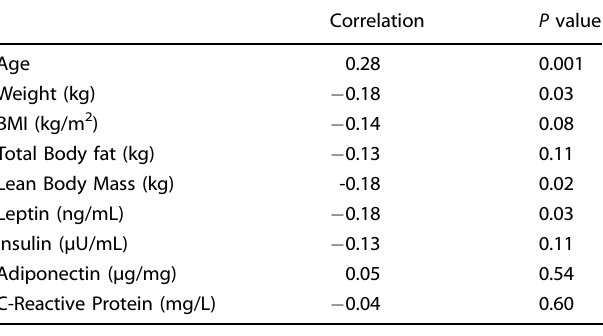
Table 2. Unadjusted baseline Pearson correlation coef fi cients of ghrelin levels with age, measurements of body composition, and serum biomarkers in all study participants ( n =